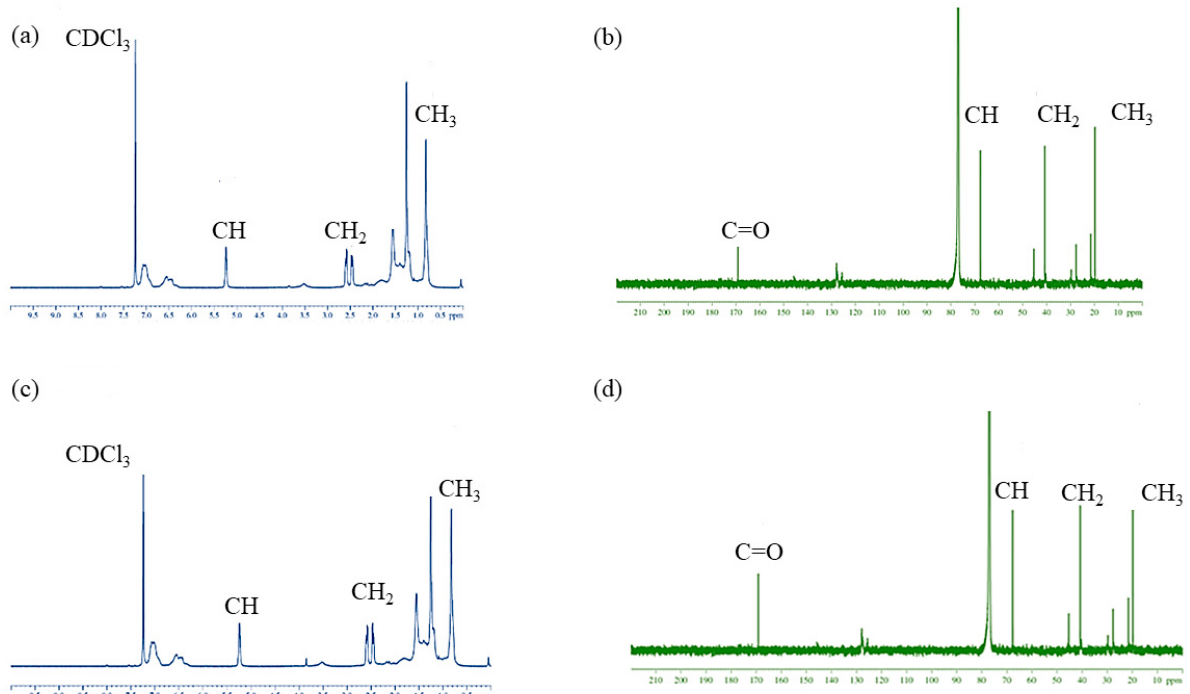
Figure 5. 1 HNMR and 13 CNMR analysis of PHB and PHB-CB, ( a ) 1 HNMR for PHB, ( b ) 13 CNMR for PHB, ( c ) 1 HNMR for PHB-CB and ( d ) 13 CNMR for